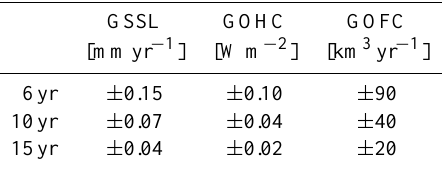
Table 2. A “forecast calculation” of the uncertainties of global trend estimations assuming GOI error bars during the year 2010 while applying Eq. (A1) (Appendix) for 10 and 15yr, together with the trend uncertainties of the current GOI estimation during 2005– 2010. These values do not take into account uncertainties induced by remaining systematic errors in the Argo observing system. GSSL GOHC GOFC [mmyr − 1 ] [Wm − 2